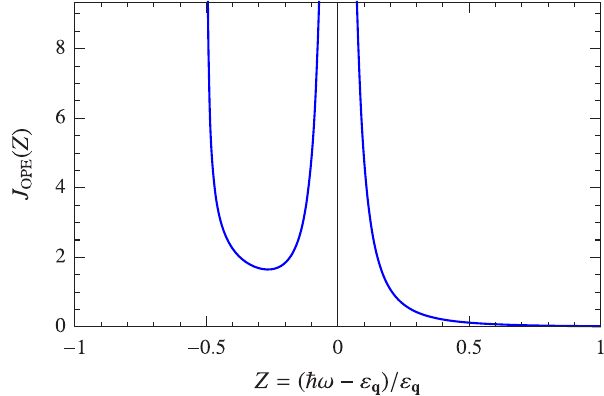
Z Þ as given in Eq. (16) as a FIG. 3. Scaling function J OPE ð function of the scaling variable Z ¼ ð ℏ ω − ε q Þ = ε q . The scaling function is symmetric near Z ¼ 0 but is strongly asymmetric for j Z j ¼ O ð 1 Þ